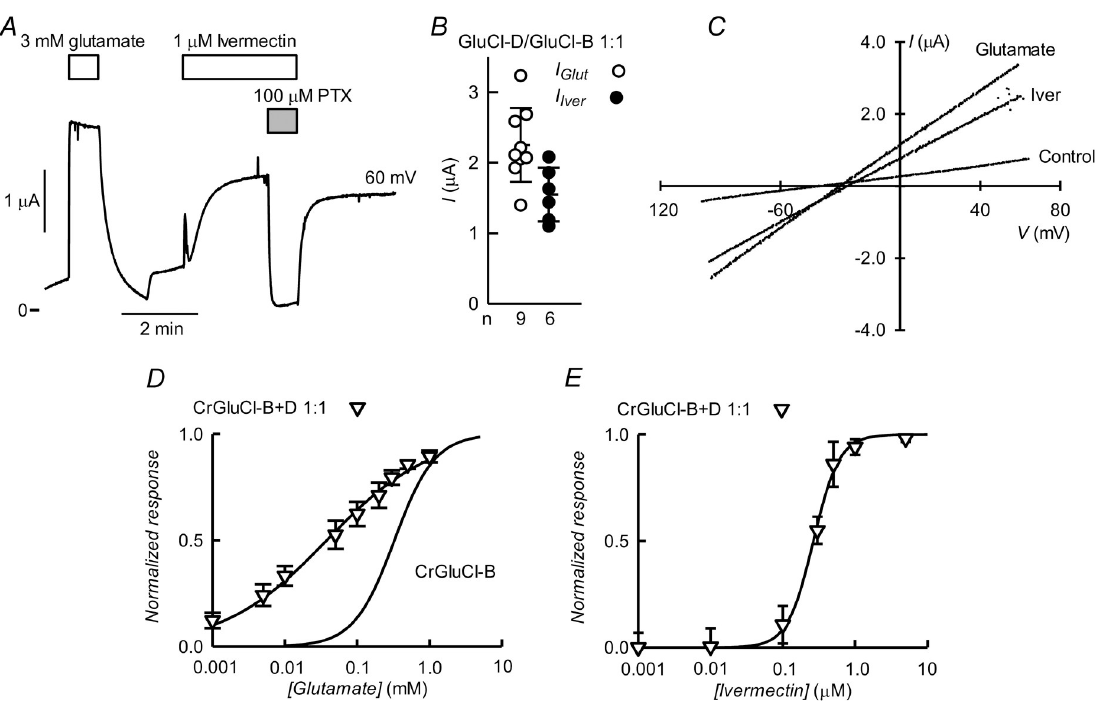
Fig 10. Functional properties of coexpressed CrGluCl-D and CrGluCl-B in Xenopus oocytes. A. Currents elicited by 3 mM glutamate or 1 μ M ivermectin in an oocyte expressing subunits D and B 48–72 h after microinjection of 10ng cRNA for each CrGluCl-D and CrGluCl-B. Recording taken at 60 mV. B. Summary of currents elicited by glutamate or ivermectin in oocytes expressing CrGluCl-D and CrGluCl-B in 1:1 proportion. Total cRNA injected was always 20 ng. Individual data and means ± SDs are shown with n values given under the abscissa. C. IV relations corresponding to control before any addition or during the glutamate or ivermectin challenges. D. Dose-response relationship of the glutamate-sensitive currents of CrGluCl-D:CrGluCl-B mixed expression experiments. Data are normalized (mean ± SD, n = 6) to the maximal effect of glutamate. The line is a Hill equation fit. Data for CrGluCl-B individual expression from Fig 3 is shown for comparison. E. Dose-response relationship of the ivermectin-sensitive currents of CrGluCl-D:CrGluCl-B mixed expression experiments. Data are normalized (mean ± SD, n = 6) to the maximal effect of glutamate. The line is a Hill equation fit.